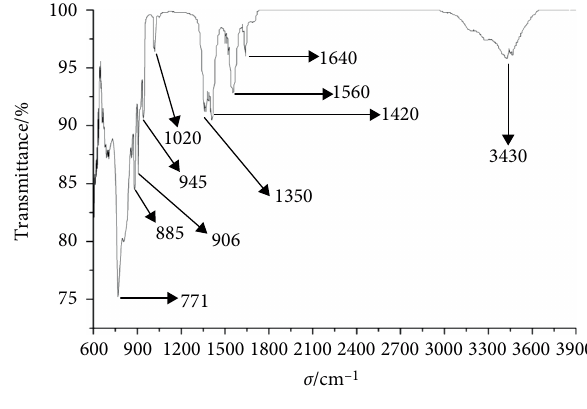
Figure 2: FT-IR spectrum of